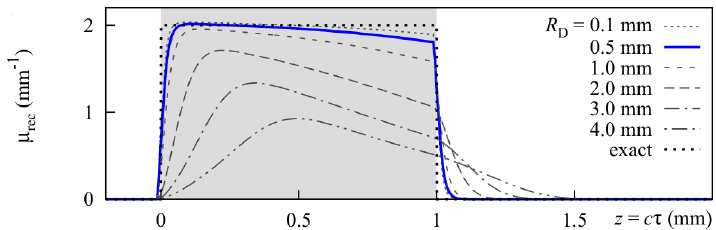
Figure 20. Absorption coefficient profile µ a ( s ) as reconstructed from the initial pressure profile obtained by the inverse solution in terms of the optoacoustic Volterra integral equation. The detector radius R D is crucial for the accuracy of the reconstruction. Realistic dimensions as found in our optoacoustic setup for clinical application are marked in blue and still show very good agreement to the exact (constant) result (reproduced with permission from